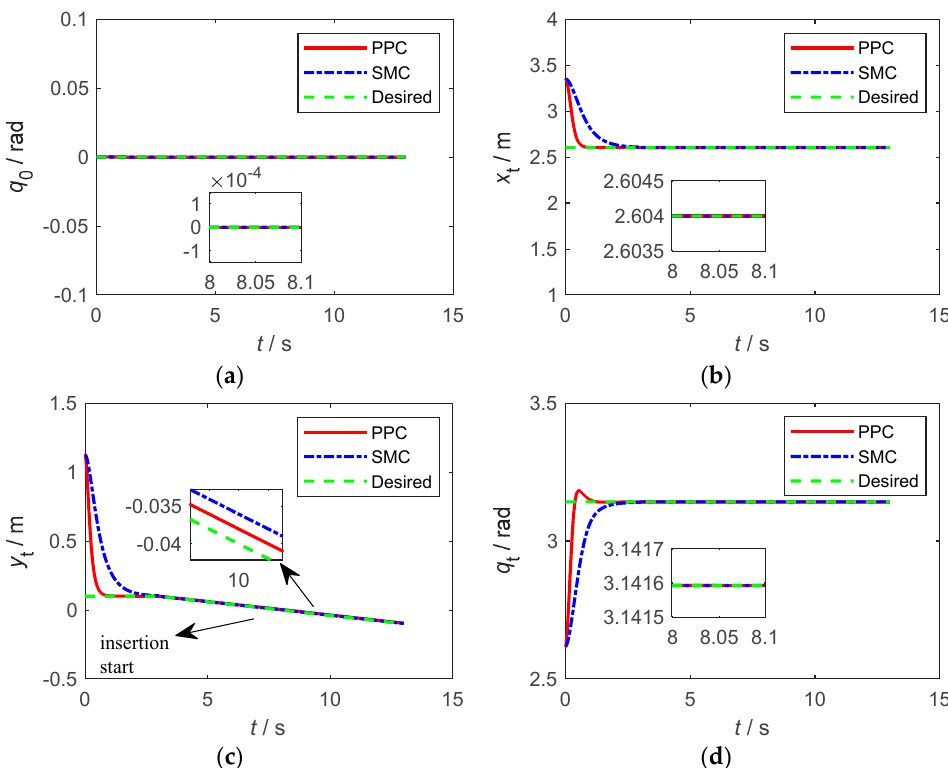
Figure 4. Space robot end trajectory tracking curve of on-orbit insertion operation. ( a ) The carrier attitude, ( b ) The X-direction position, ( c ) The Y-direction position, ( d ) The space robot end attitude. Figure 5 shows the joint trajectory tracking curve.